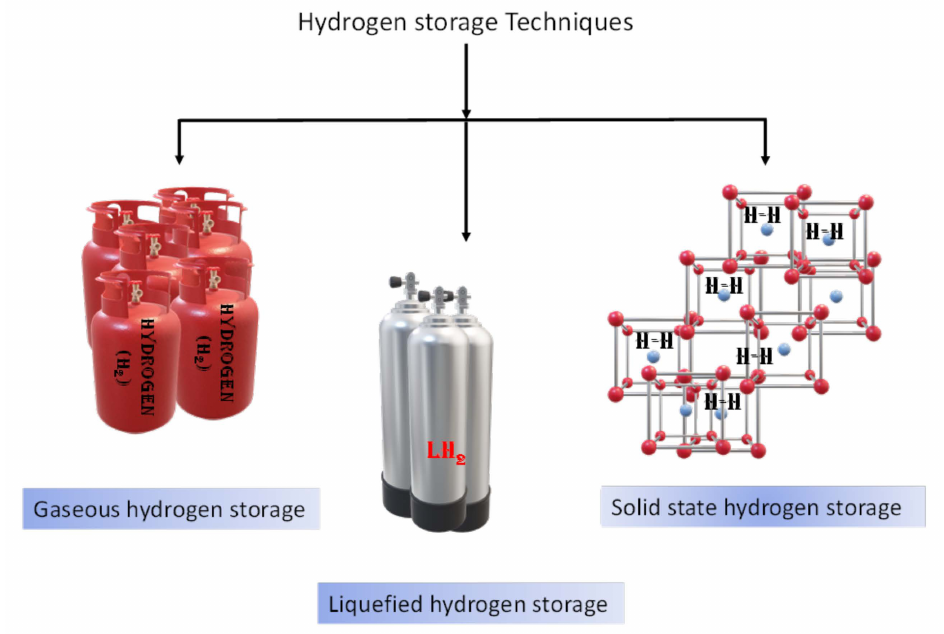
Figure 1. Different hydrogen storage